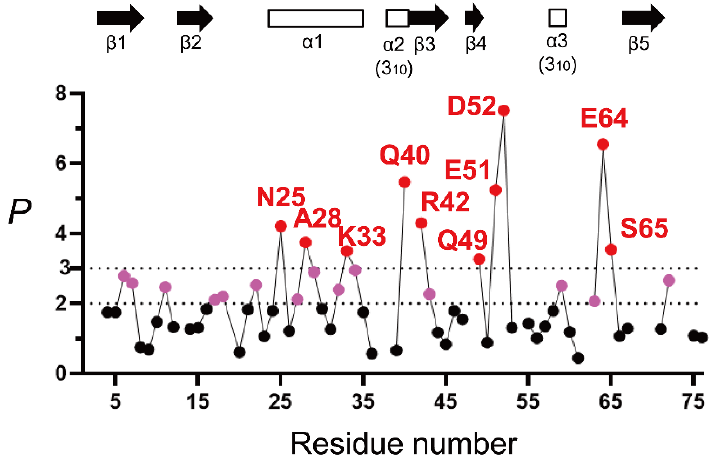
Figure 4. The H/D-exchange protection profile of unfolded ubiquitin in 6 M GdmCl, represented by P as a function of the residue number (pH* 3.3 and 15 °C). The dashed lines indicate the P values of 2 and 3. The amino-acid residues with P values larger than 2 and 3 are indicated in pink and red, respectively, and the other residues in black. The locations of the secondary structures in native ubiquitin (PDB code: 1UBQ) are shown by arrows (β -strands) and open rectangles (helices). The k obs values for the majority of NH protons were obtained by three independent H/D-exchange experiments, and the percent standard error estimate of k obs was ~8%, indicating that the P value of 2.0 can be written as P = 2.0 ± 0.16 (see [136] for the complete list of the standard error estimates of k obs values). Adapted with permission from Ref. [136]. Copyright 2020 Biophysical Society.